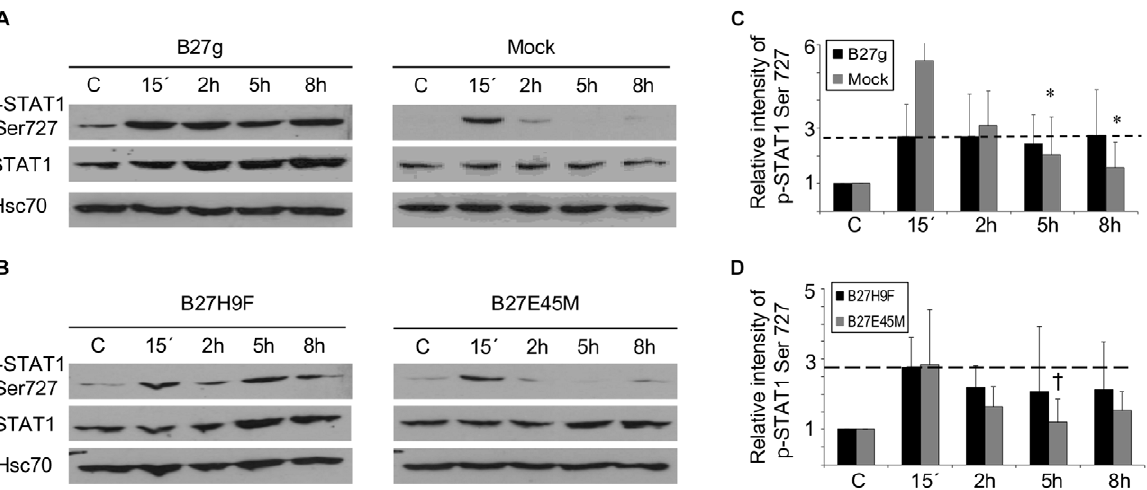
Figure 1. Prolonged phosphorylation of STAT-1 serine 727 in cells expressing misfolding forms of HLA-B27 molecule. U937 transfectants were PMA-maturated, infected with Salmonella enteritidis , and harvested at the indicated time points after excess bacteria were washed away. The phosphorylation of STAT-1 serine 727 was studied by Western blot method with p-STAT-1 Ser727 antibody. Cell extracts (35 m g of each) were loaded on SDS-page gel. A , The representative figure of U937 cells transfected with genomic clones of HLA-B27 (B27g) or with vector alone (mock). ‘‘C’’ denotes uninfected cells. B , The representative figure of U937 cells transfected with mutated, misfolding form of HLA-B27 (B27H9F) or with mutated, non-misfolding form of HLA-B27 (B27E45M). C , The relative intensity of STAT-1 serine 727 phosphorylation in B27g-expressing cells and in mock cells. The bars show the mean 6 SD of 6 independent experiments. D , The relative intensity of STAT-1 serine727 phosphorylation in B27H9F- and B27E45M-transfected cells. The bars show the mean 6 SD of 5 independent experiments. Blots were stripped and reprobed with STAT-1 antibody and Hsc70 antibody as a loading control. The relative intensity of p-STAT1 Ser 727 was calculated as the intensity of the phosphorylated band divided by the intensity of the respective loading control and normalized to the uninfected control (C, which is given value one). *= P , 0.05 and { = P , 0.07 versus 15 min time point of the respective cell line.